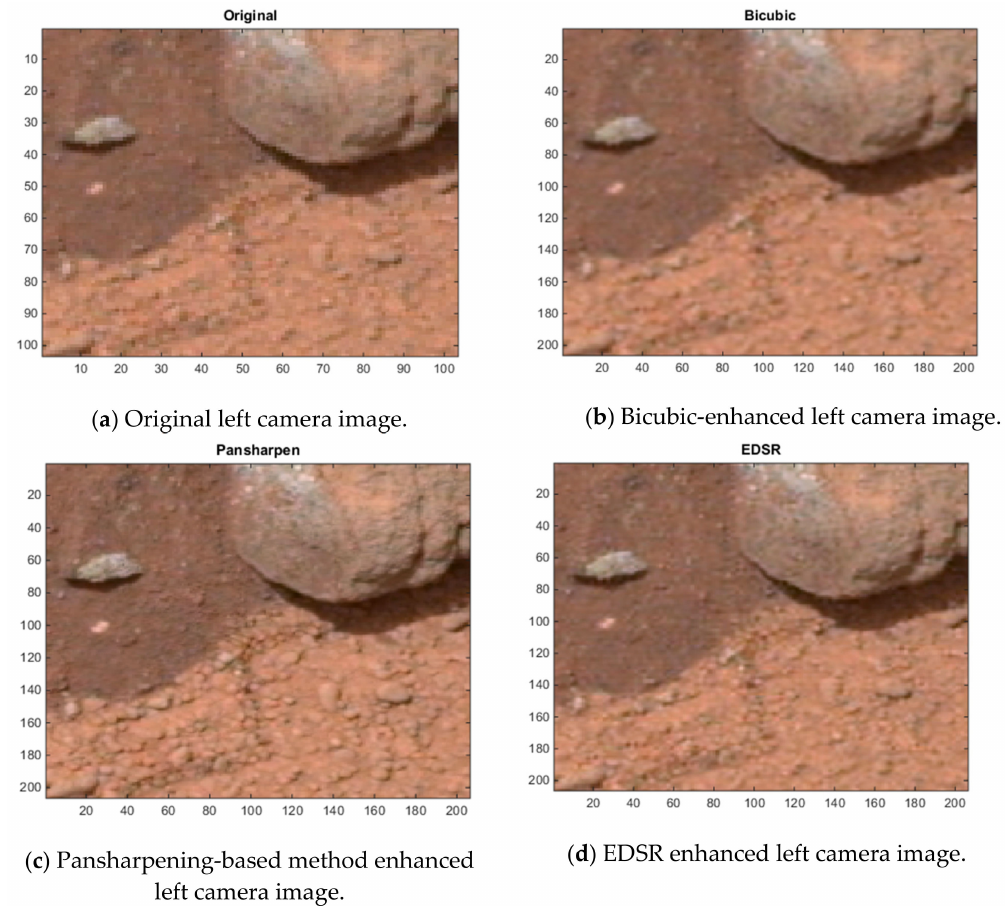
Figure 12. Image enhancements on